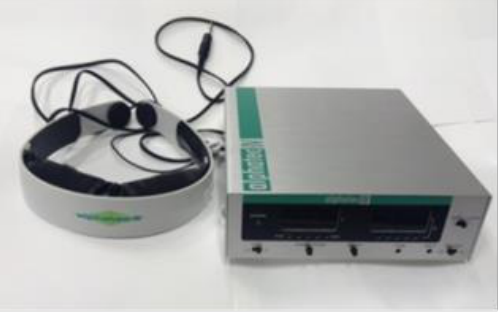
Figure 1. Brain wave meter.